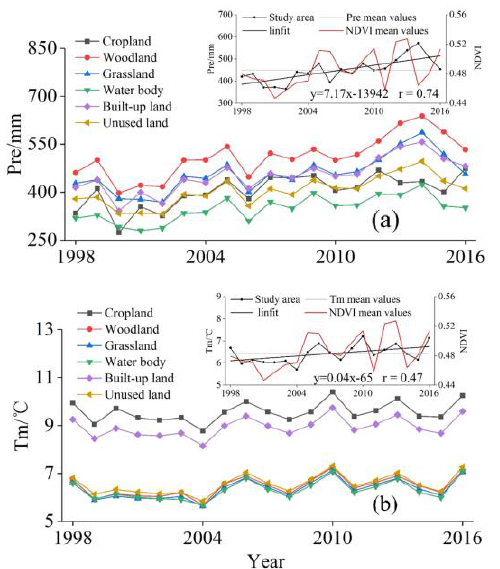
Figure 4. Temporal change of the climate elements in region from 1998 to 2016: (a) precipitation; (b)